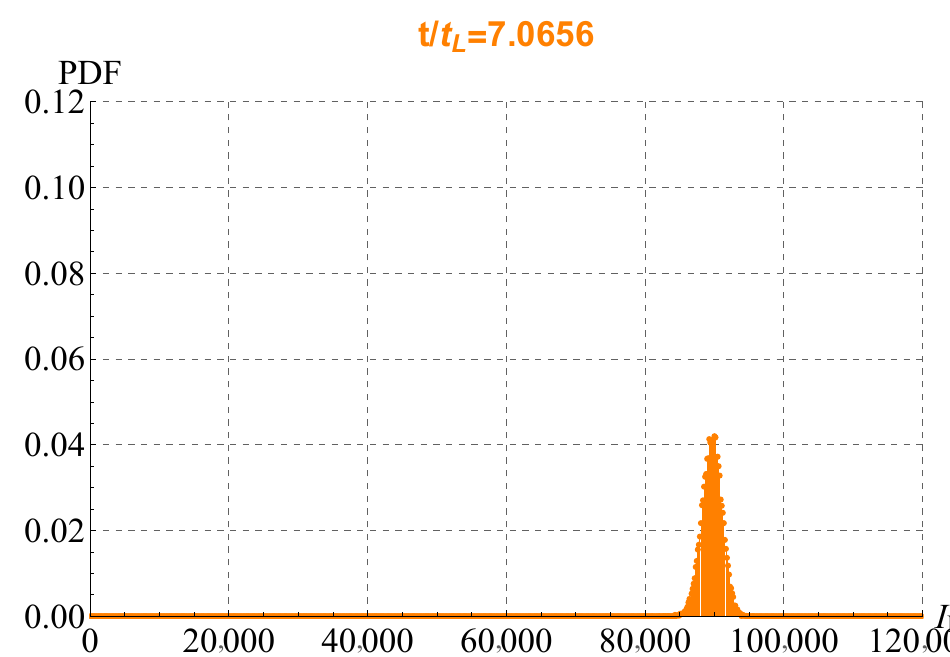
Figure 14. Probability density function (PDF), solution of Equation (36) for Italy, first wave of infection by SARS-CoV-2. Screenshoot at time ˆ t = 7.0656.